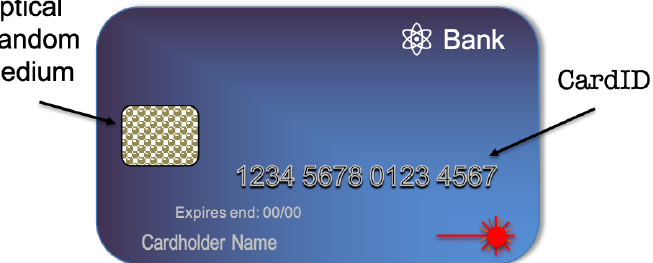
Figure 1. Schematic representation of an optical token. The token resembles a conventional smart card, where the chip is replaced by a disordered optical multiple-scattering